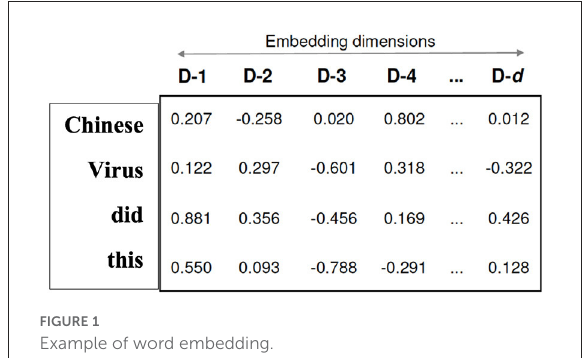
FIGURE1 Example of word